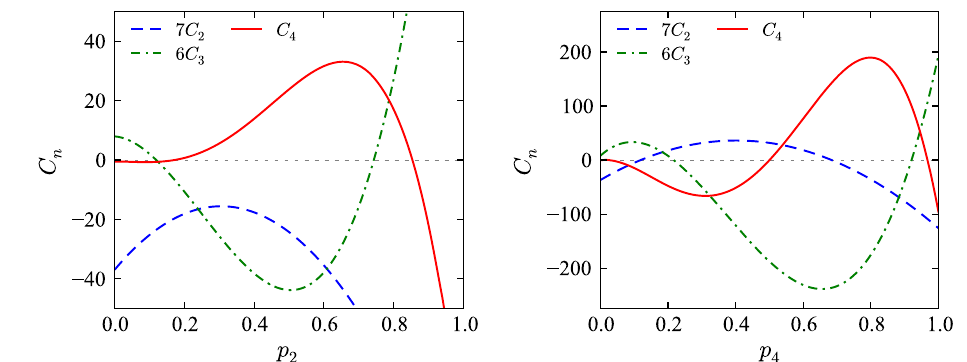
ity bin. For larger values of p 2 and p 4 we obtain large values of C 3 and C 4 . See the text for further